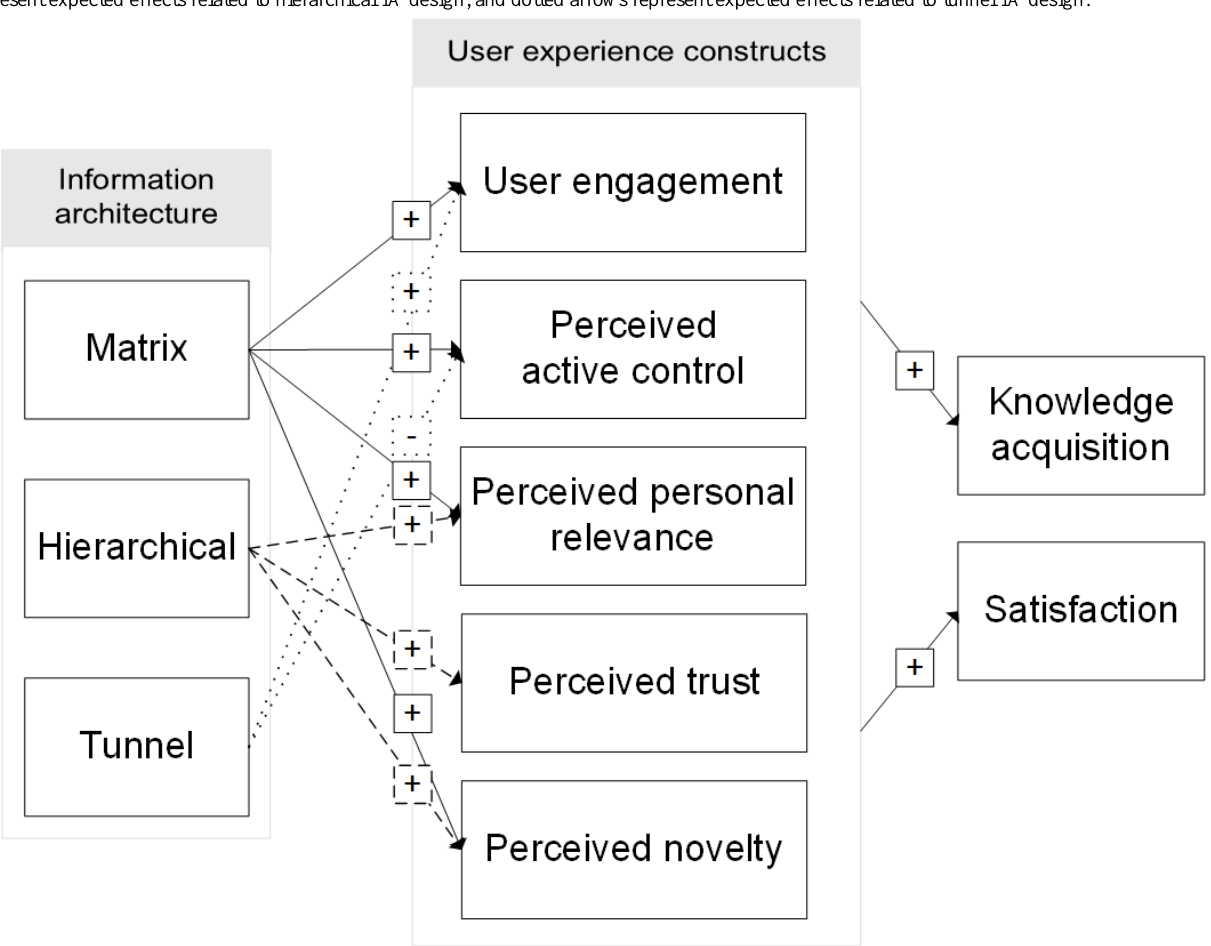
Figure 1. Conceptual model of information architecture (IA). Solid arrows represent expected effects related to matrix IA design, dashed arrows represent expected effects related to hierarchical IA design, and dotted arrows represent expected effects related to tunnel IA